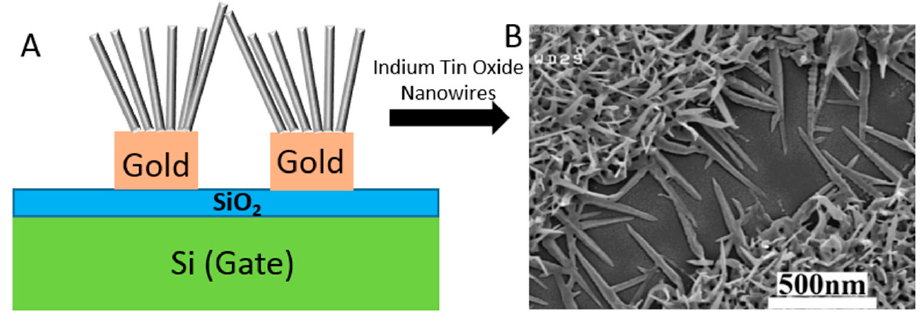
Figure 19. The configuration of ITONWs-FET genosensor. ( a ) Si/SiO 2 /Au/ITONWs device; ( b ) the FESEM images of indium tin oxide (ITO) samples. FESEM images of indium tin oxide (ITO)